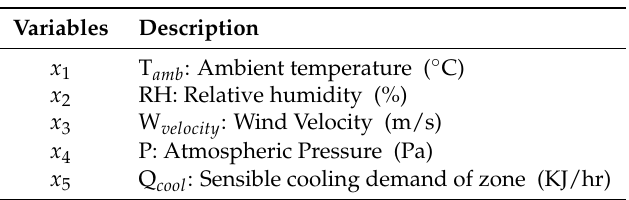
Table 7. Variables description.